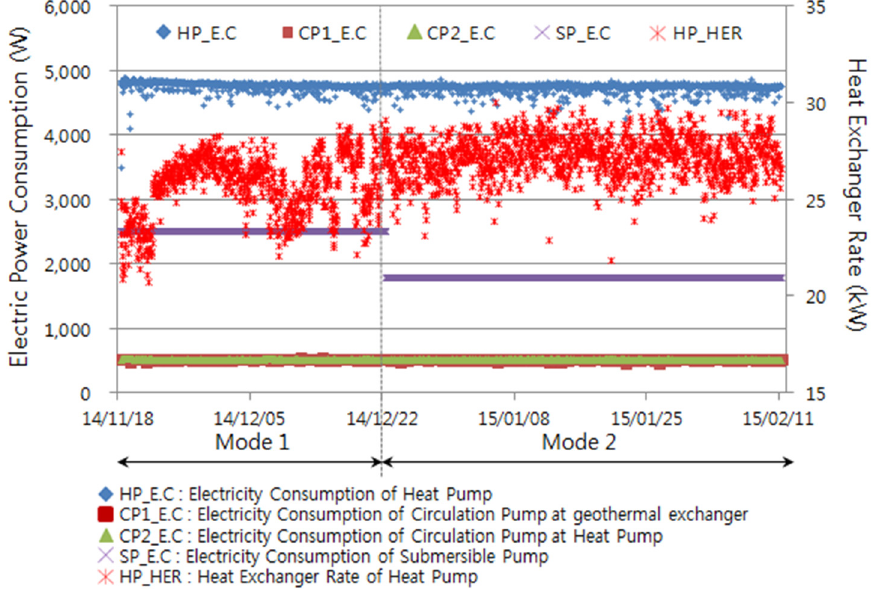
Figure 5. Heat exchanger rate and power consumption of the system.